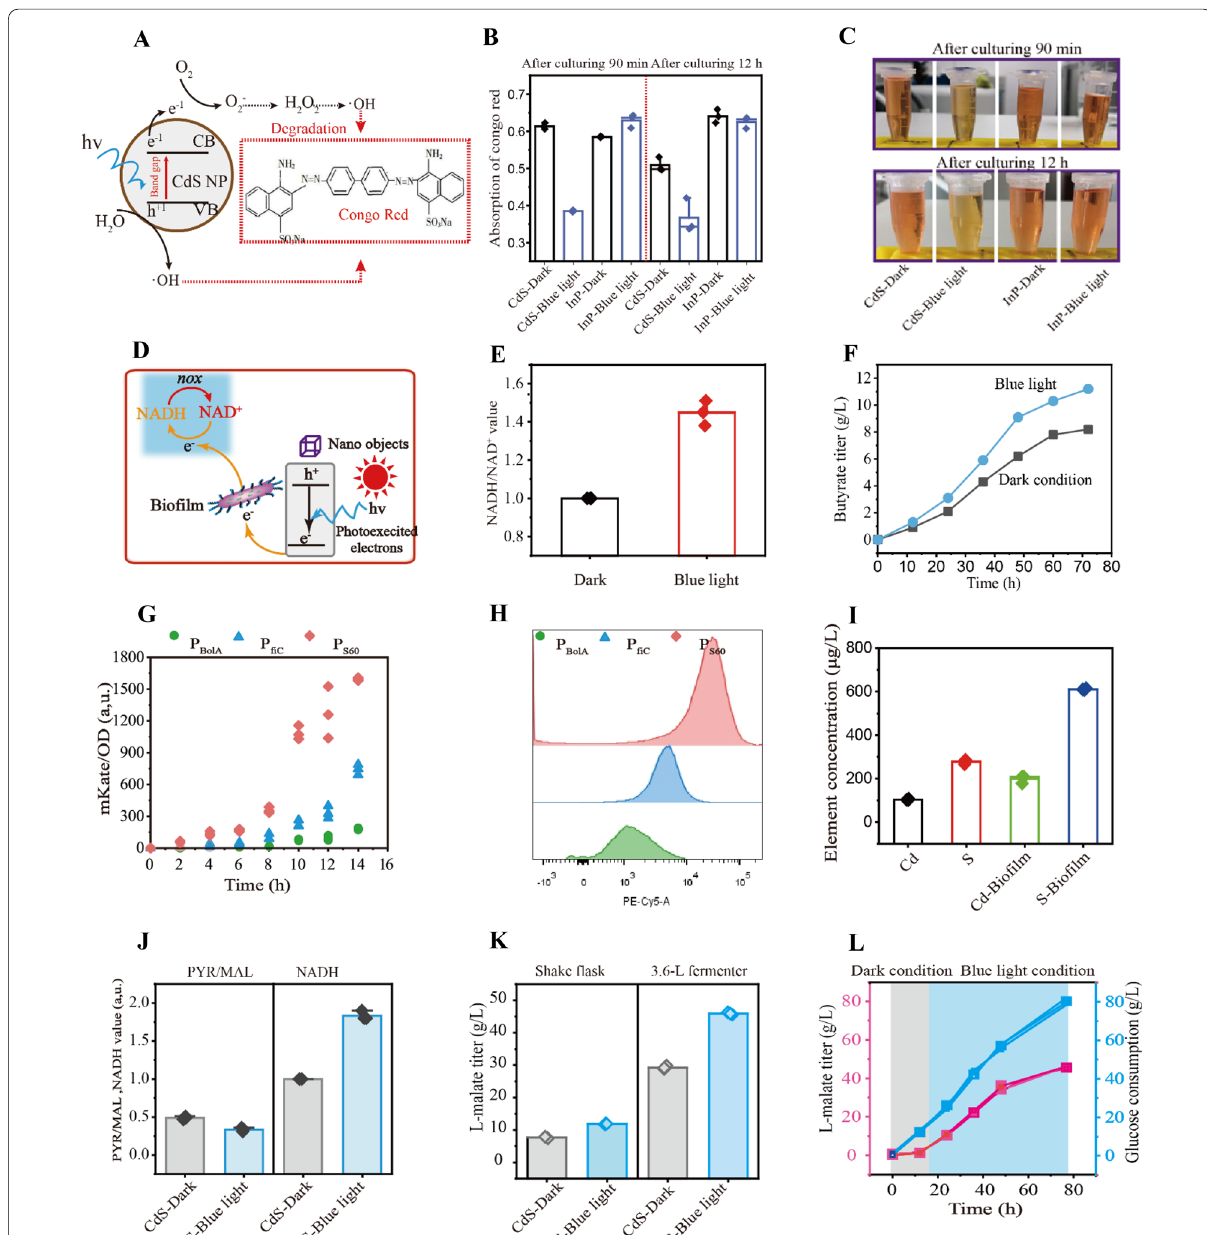
Fig. 6 Enhancing L-malate production by biofilm biohybrid system. A – C The congo red degradation assay with or without blue light irradiation in the CdS- or InP-biohybrid system. D , E NADH regeneration in NOX overexpressing strain under the dark or blue light conditions. F Butyrate titer with CdS-biohybrid system under the blue light or dark conditions. G Fluorescence activation with different stationary phase promoters. H Fluorescence activation with different stationary phase promoters through flow cytometer analysis. I Comparing the CdS nanoparticle concentration with different conditions. J Comparing the pyruvate/L-malate and NADH value with different conditions. K L-malate production with the engineered E. coli M6 controlled by light irradiation during 3.6 L fed-batch fermentation. L L-malate production in the 3.6 L fermenter with two-stage fermentation. For B, E-L, n =